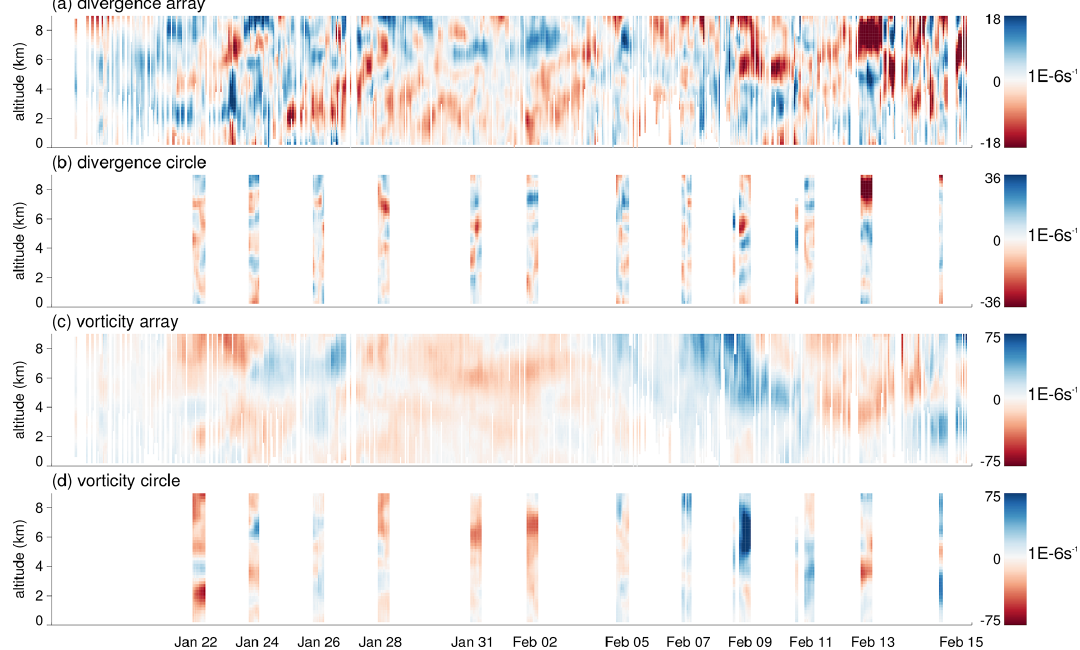
Figure 3. (a, b) Divergence and (c, d) vorticity anomalies derived from 3D-Var applied to (a, c) the sounding network and (b, d) the HALO circles.